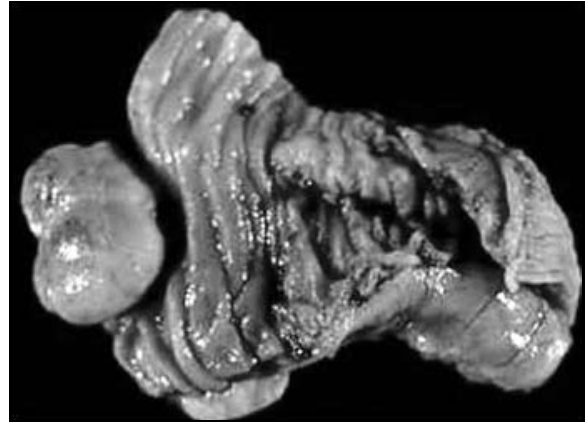
Figura 1 – GIST gástrico de pequenas